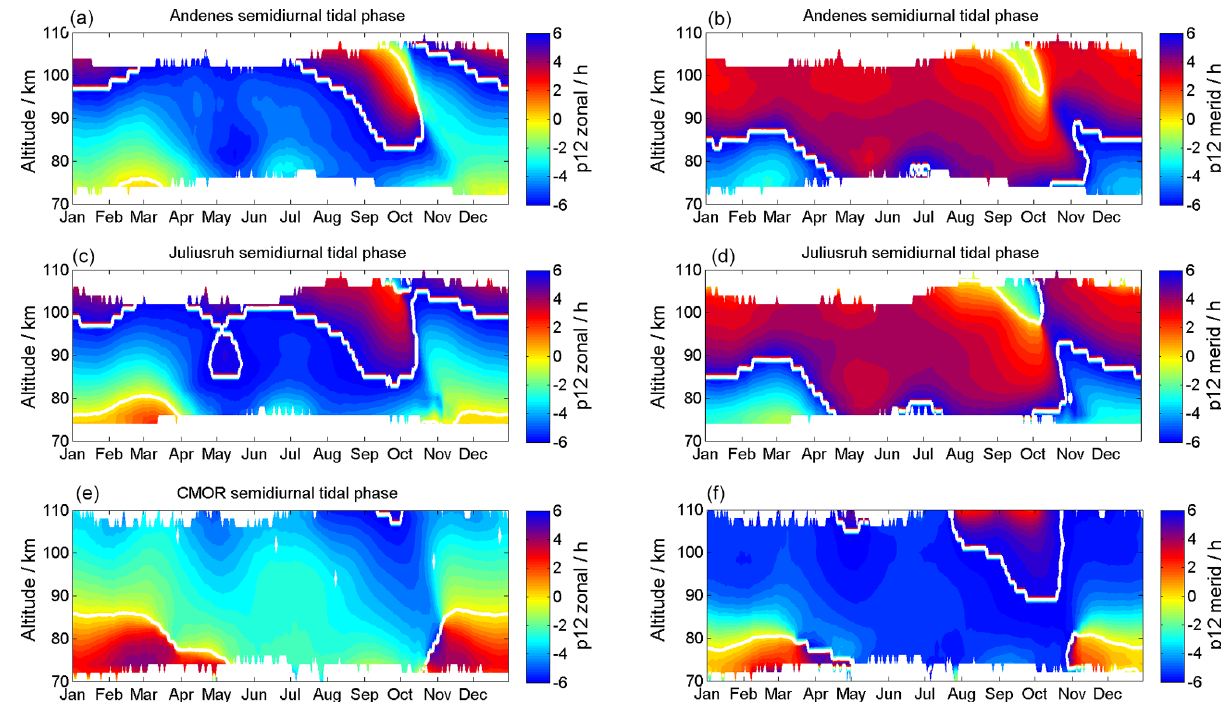
Figure 13. Same as Fig. 9 but for the semidiurnal tidal components.